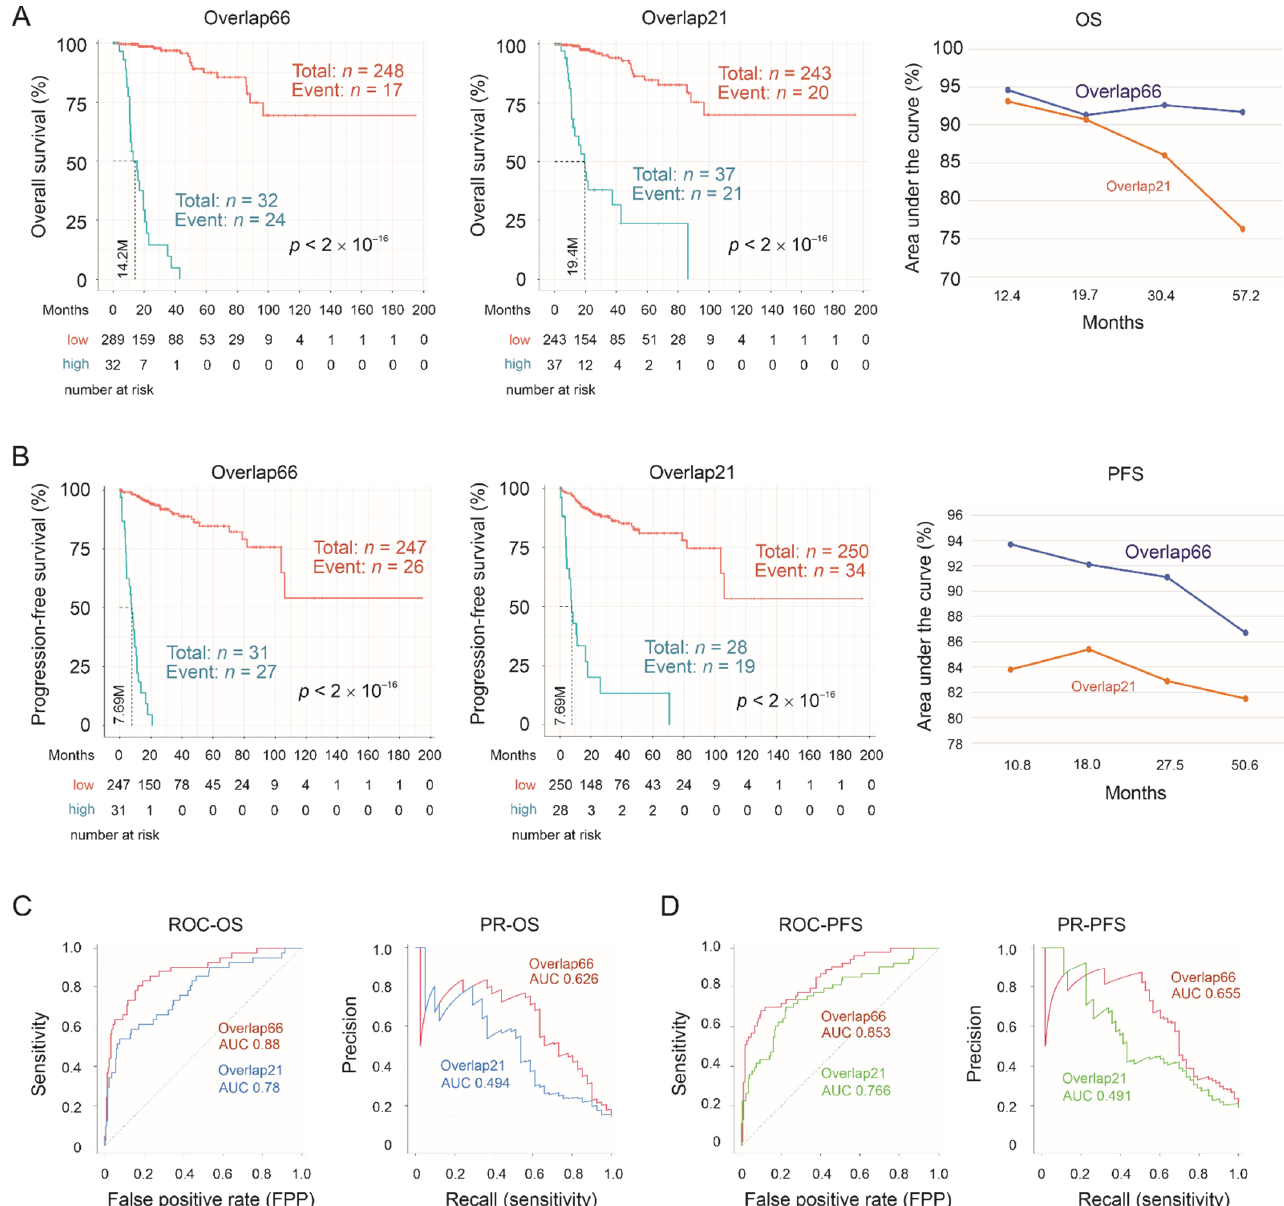
Figure 5. Stratification of the possibilities of overall survival (OS) and progression-free survival (PFS) by Overlap66 and Overlap21. ( A , B ) Cutoff points were determined by Maximally Selected Rank Statistics for the risk scores of Overlap66 (see Figure S9) and Overlap21. Kaplan Meier curves for OS ( A ) and PFS ( B ) are constructed, using the R survival package, with the populations at risk in the indicated follow-up period included. Statistical analyses were performed using logrank test. The median months of OS and PFS are indicated. Time-dependent ROC (receiver operating characteristic; tROC) curves were generated using the R timeROC package; time-dependent area under the curve (AUC) values for the indicated multigene sets are shown. ( C , D ) ROC and precision-recall (PR) curves for Overlap66 and Overlap21 in predicting OS and PFS possibilities were produced using the R PRROC.